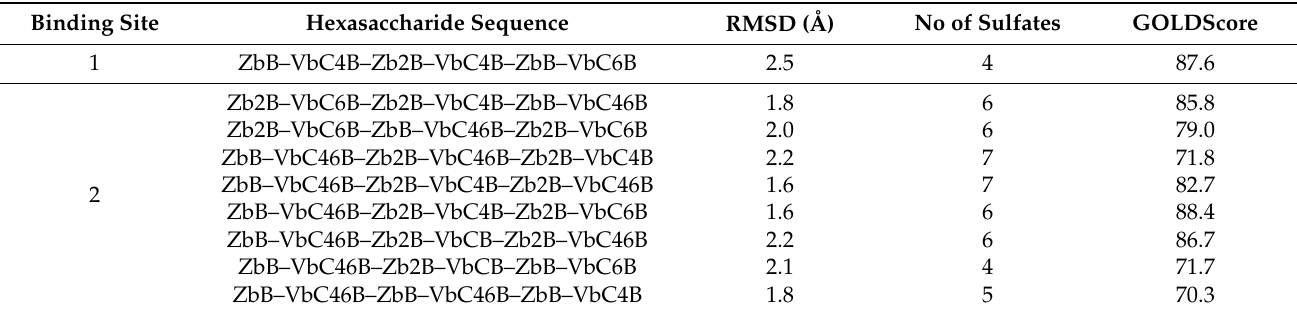
Table 3. CS hexasaccharide (CS06) sequences from the library of 1536 sequences that satisfied the dual-filter CVLS strategy for TGF- β